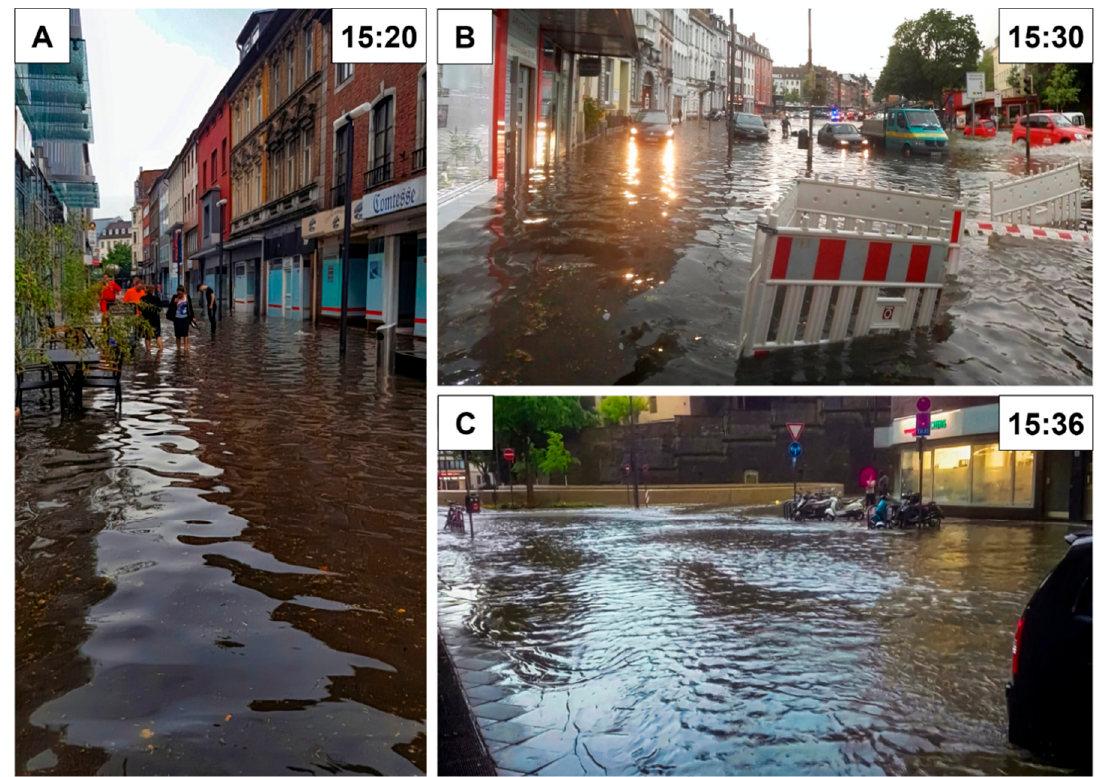
Figure 7. Flooding of the streets Adalbertstraße ( A ), Kaiserplatz ( B ), and Stiftsstraße ( C ) on 29 May 2018.